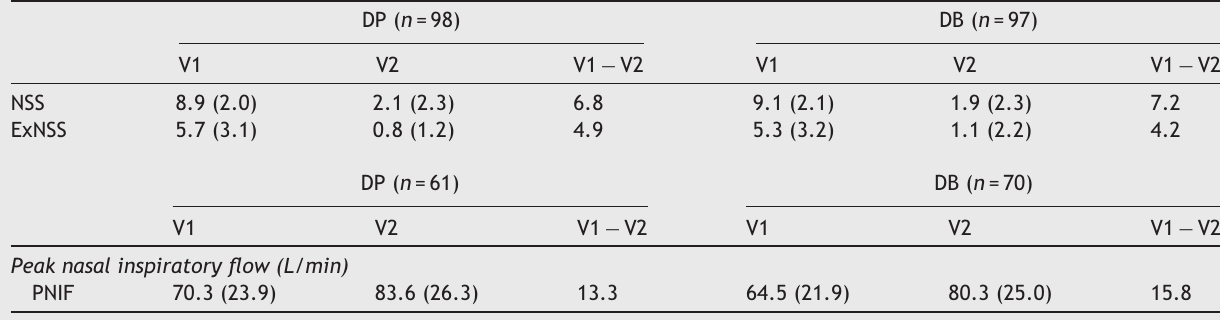
Mann---Whitney. NSS, ExNSS and PNIF-V1: DP = DB; V2: DP = DB; V1 − V2: DP = DB.